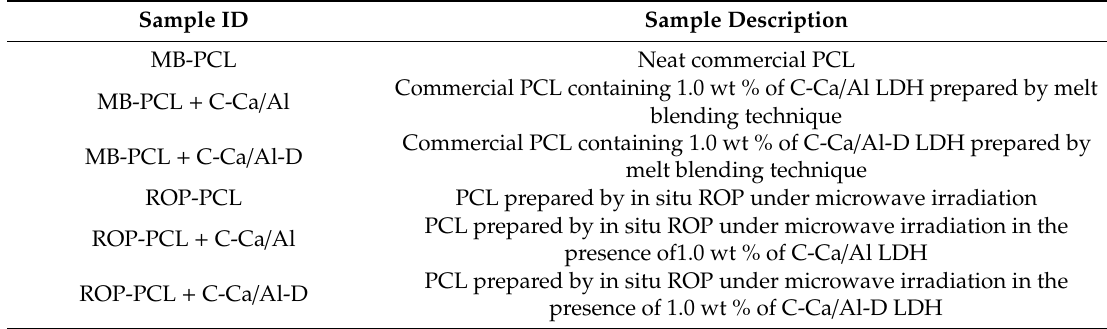
Table 1. Neat PCL and PCL-LDH nanocomposites prepared in this